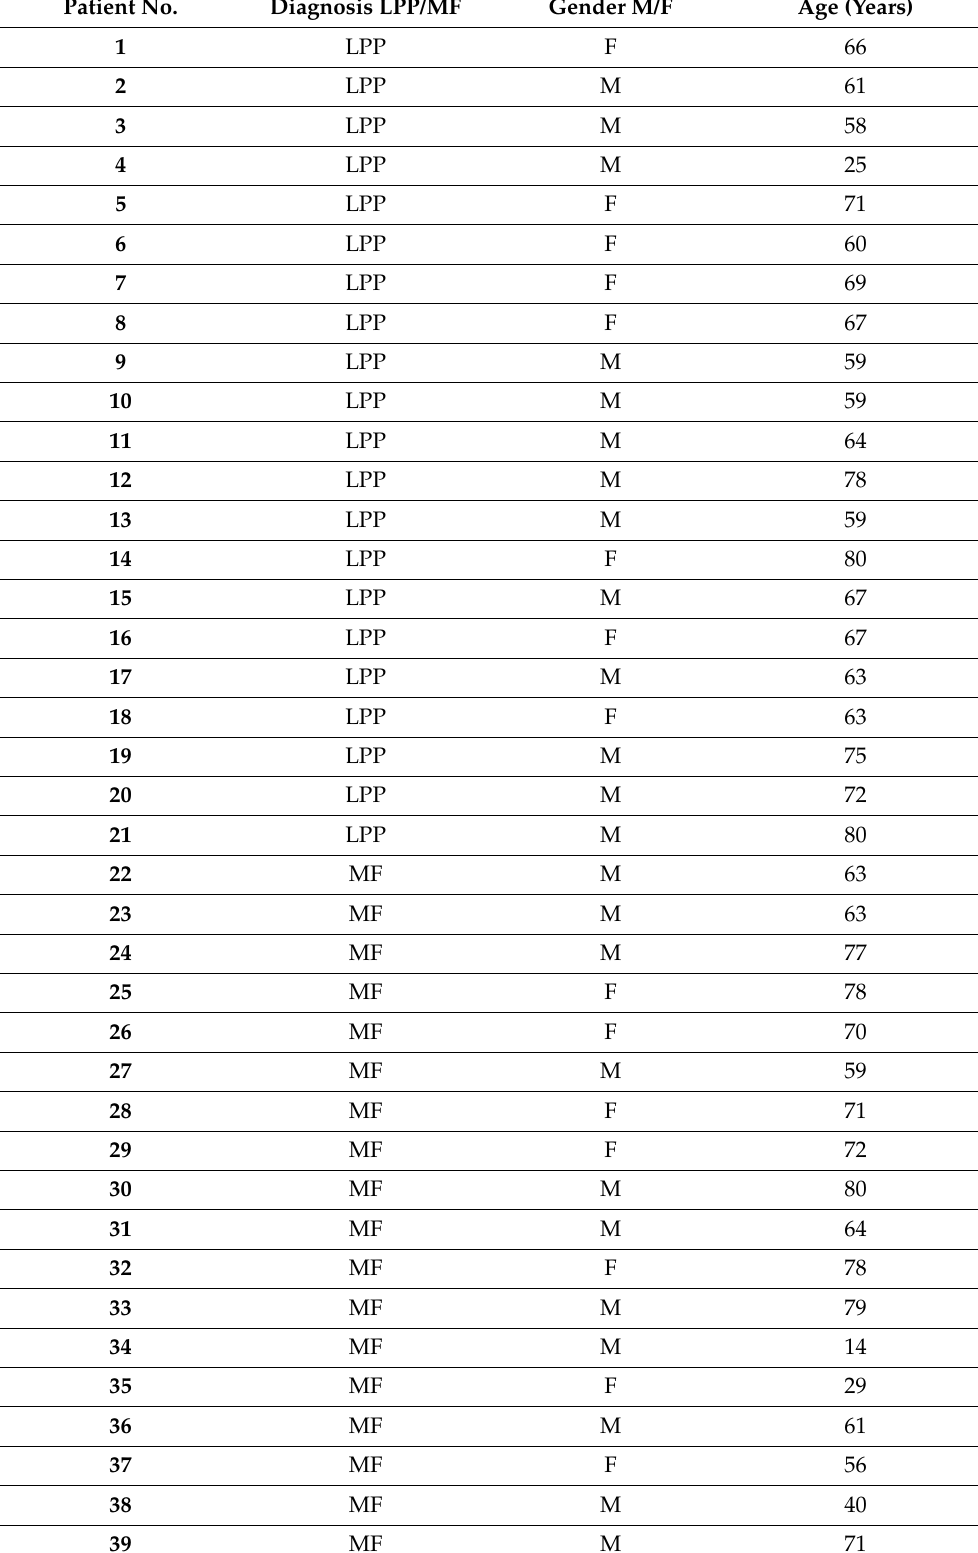
Table 2. Characteristics of the patients enrolled in the study. Patient